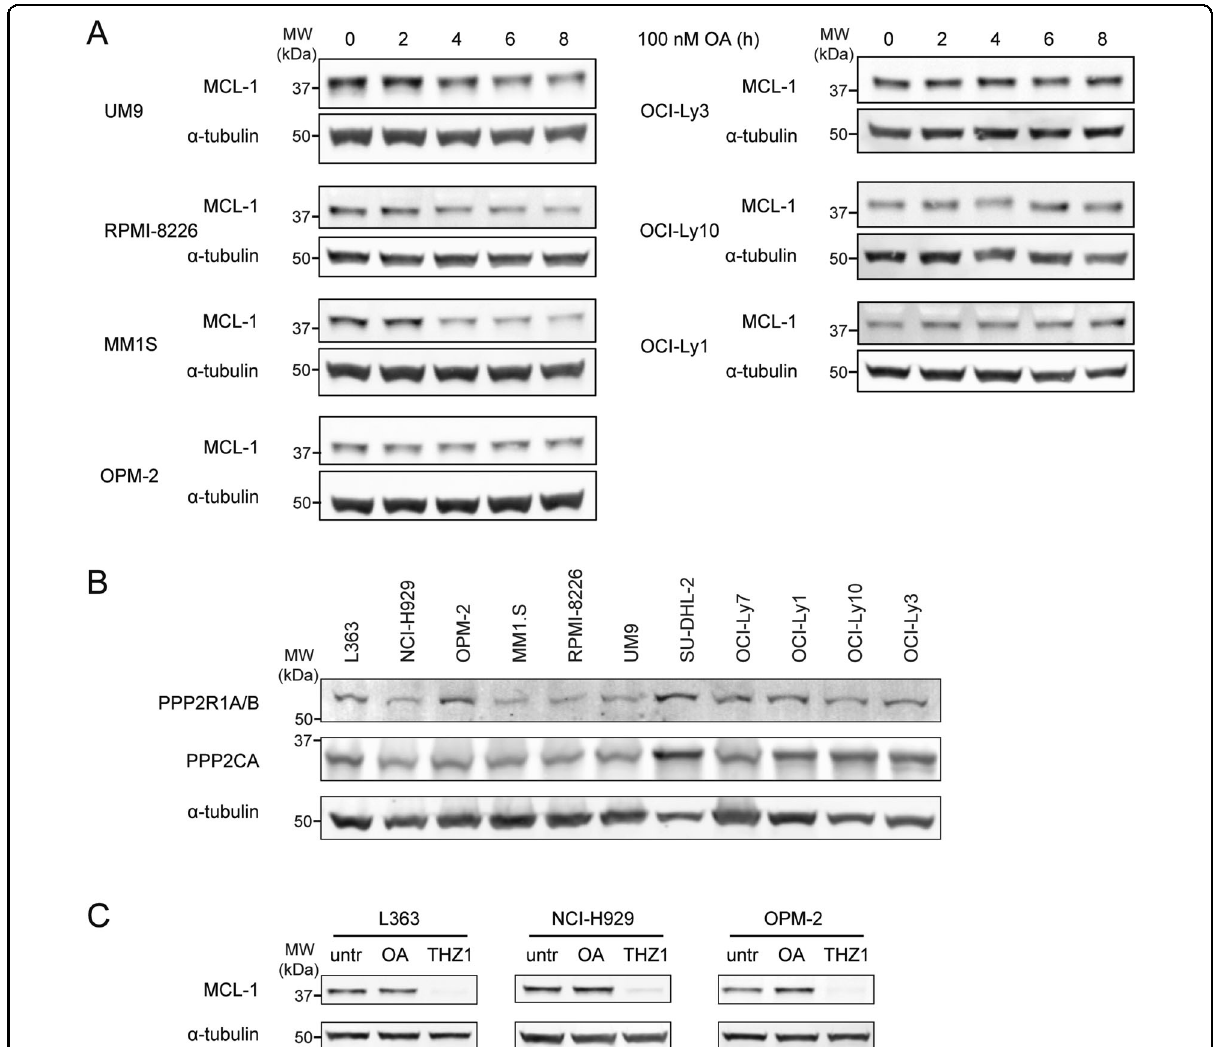
Fig. 4 PP2A prevents MCL-1 degradation in MM with long MCL-1 half-life, but not in DLBCL. A MCL-1 protein levels after treatment with 100 nM PP2A inhibitor okadaic acid (OA) for the indicated time periods in MM cell lines (left) and DLBCL cell lines (right), in the presence of 10 µM pan-caspase inhibitor Q-VD-OPh. B Expression of the PP2A catalytic subunit PPP2CA and scaffold subunits PPP2R1A/B in the MM and DLBCL cell line panel. C MCL-1 protein levels after 8 h treatment with 100 nM of OA or 200 nM of CDK7 inhibitor THZ1 in MM cell lines with short MCL-1